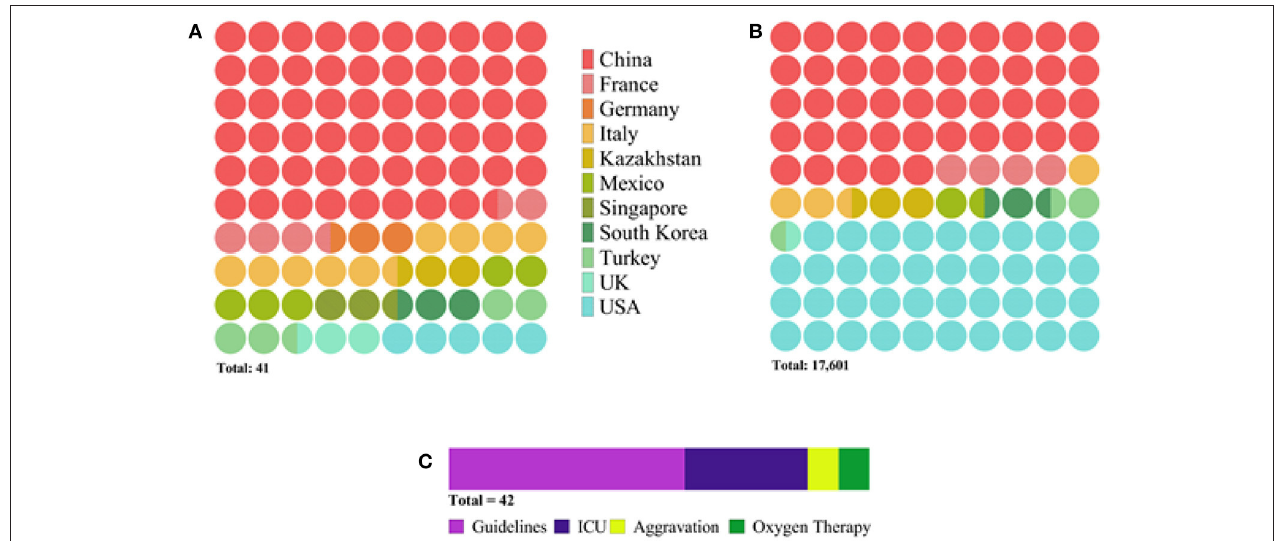
FIGURE 2 | Diagram depicting characteristics of selected studies: (A) number of publications per country, (B) number of patients per country, and (C) number of publications per severity assessment criterion. The latter (C) indicates the total number of research articles to be 42 instead of 41 because one study reported two populations of patients admitted to the hospital at different